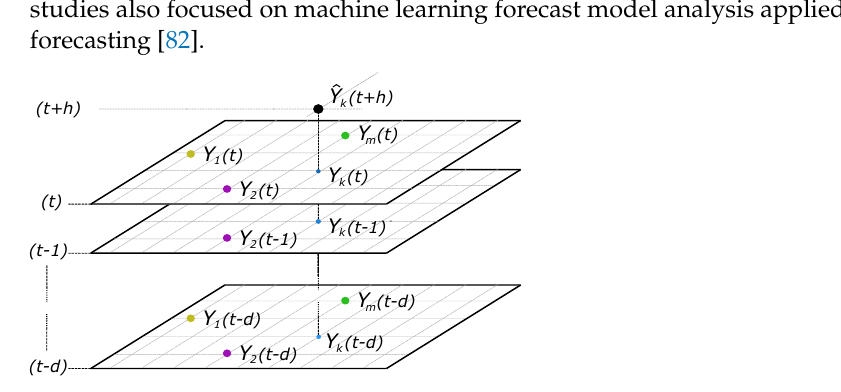
Figure 1. Smart persistence and RF model proposed for spatio–temporal forecasting.